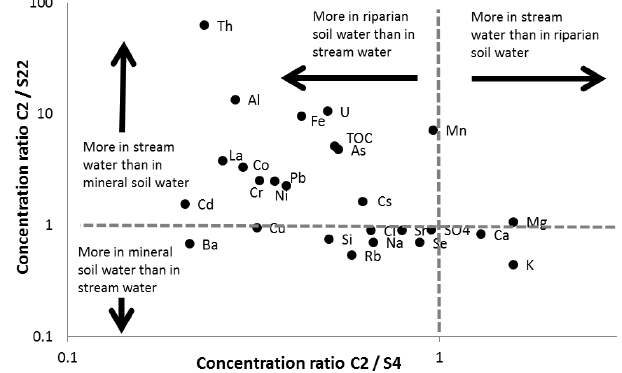
Figure 5. Enrichment in average groundwater/soil water concentra- tion when comparing the riparian zone (S4) and the upslope Podzol (S22) as a function of the affinity for organic matter. The affinity for organic matter is plotted on a logit scale (Eq. 1).